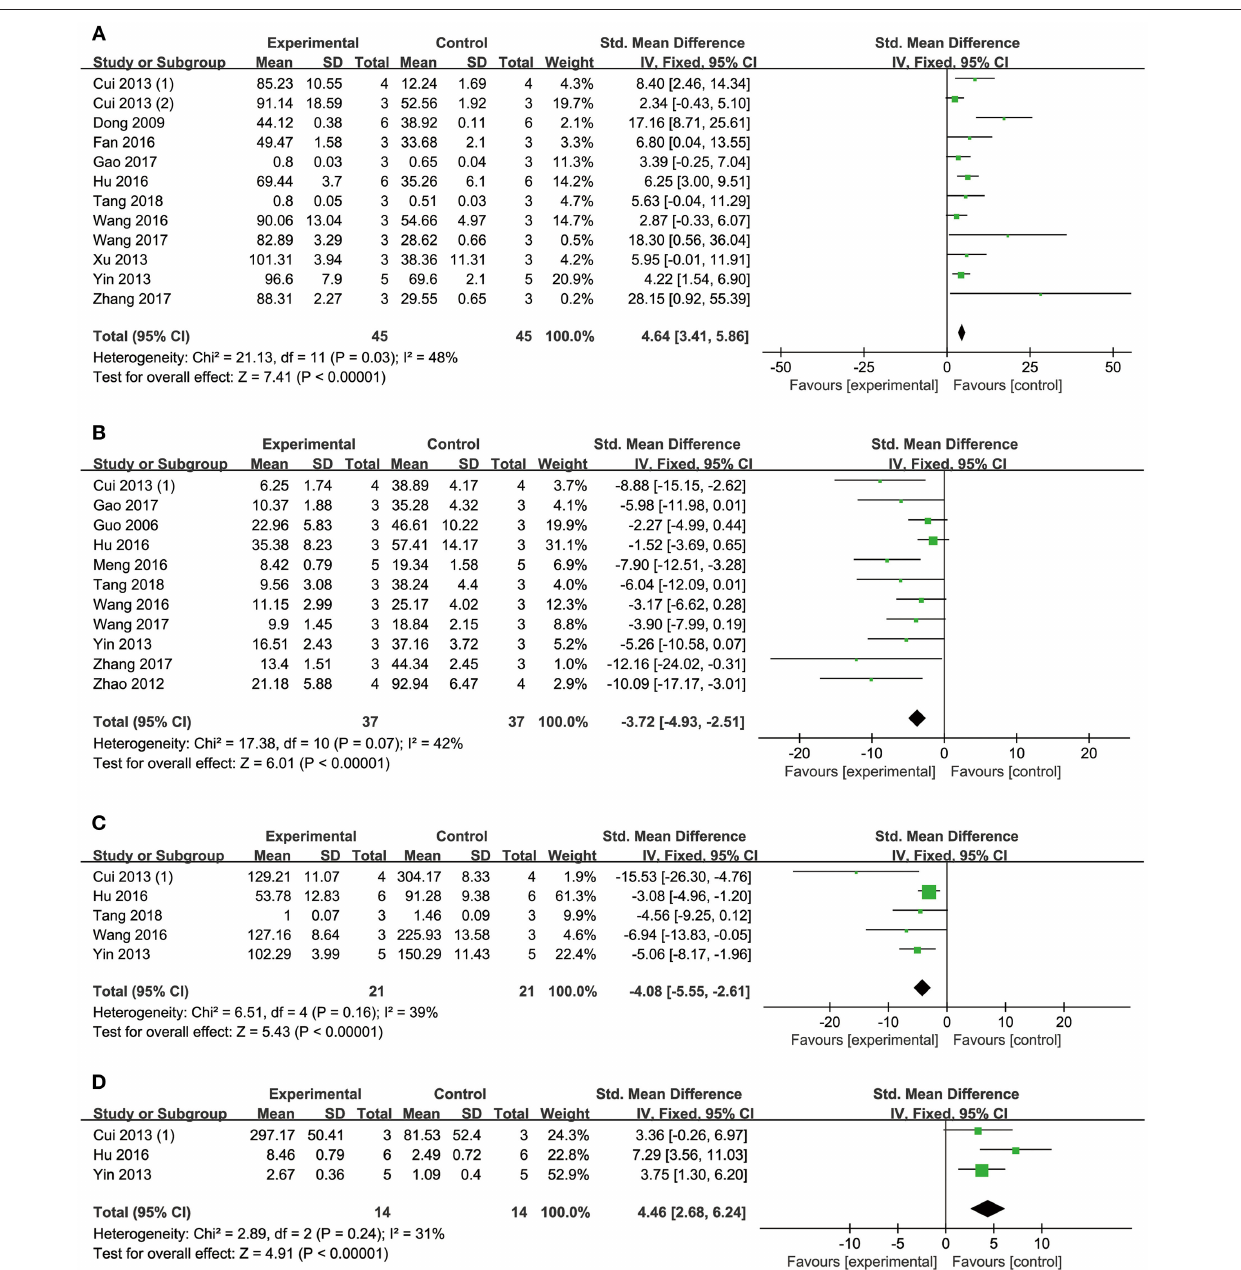
12, SMD: 2.10, 95% CI: 0.26–3.94, P = 0.03; heterogeneity summarized a schematic representation of cardioprotective mechanism of DSS for myocardial ischemic injury ( Figure 8